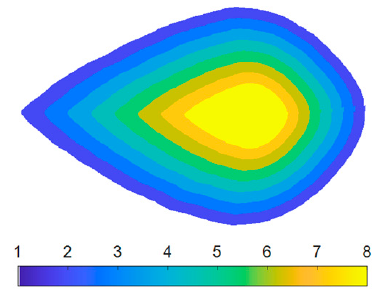
Figure 6. Eight sections on leaf image to detect the spatial variation.